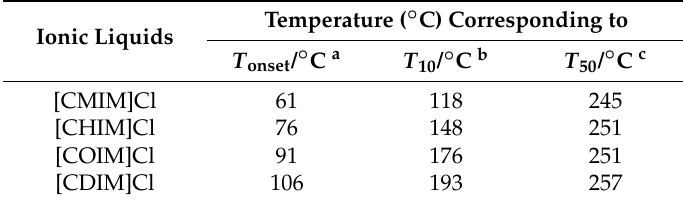
Figure 2. TG curve of different N -cinnamylimidazolium ILs. Table 1. Thermal decomposition temperatures (T onset ) of the N -cinnamylalkylimidazolium ILs.